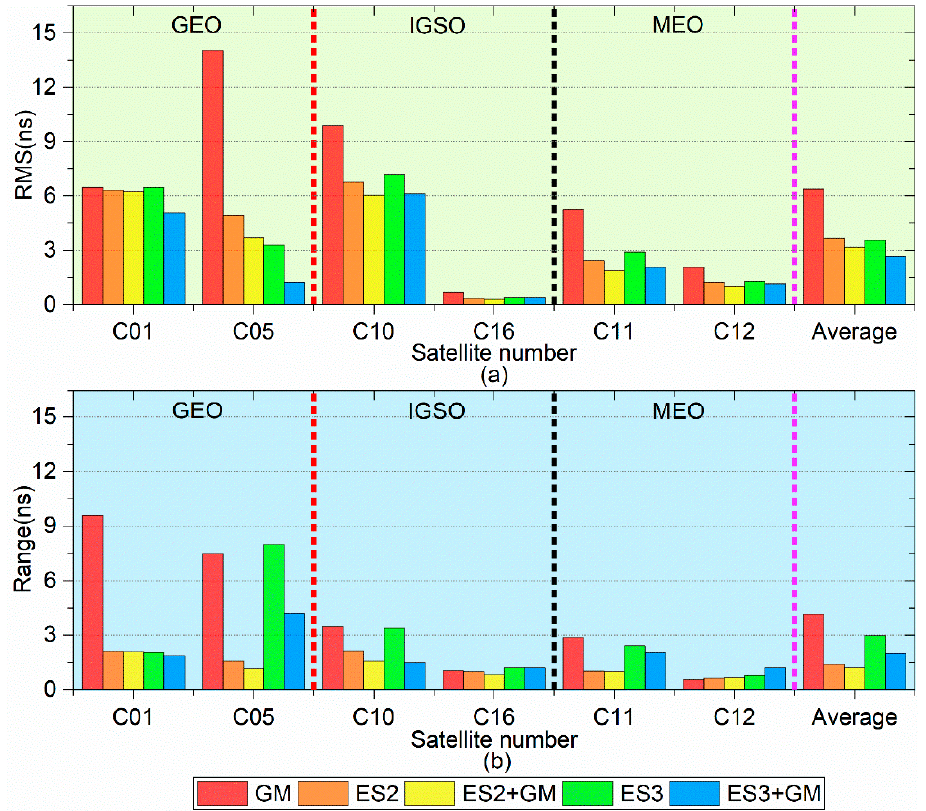
Figure 7. Variation diagram of 6 h forecast accuracy (RMS) and stability (Range) using different models: ( a ) is the changes of RMS, and ( b ) is the changes of Range.